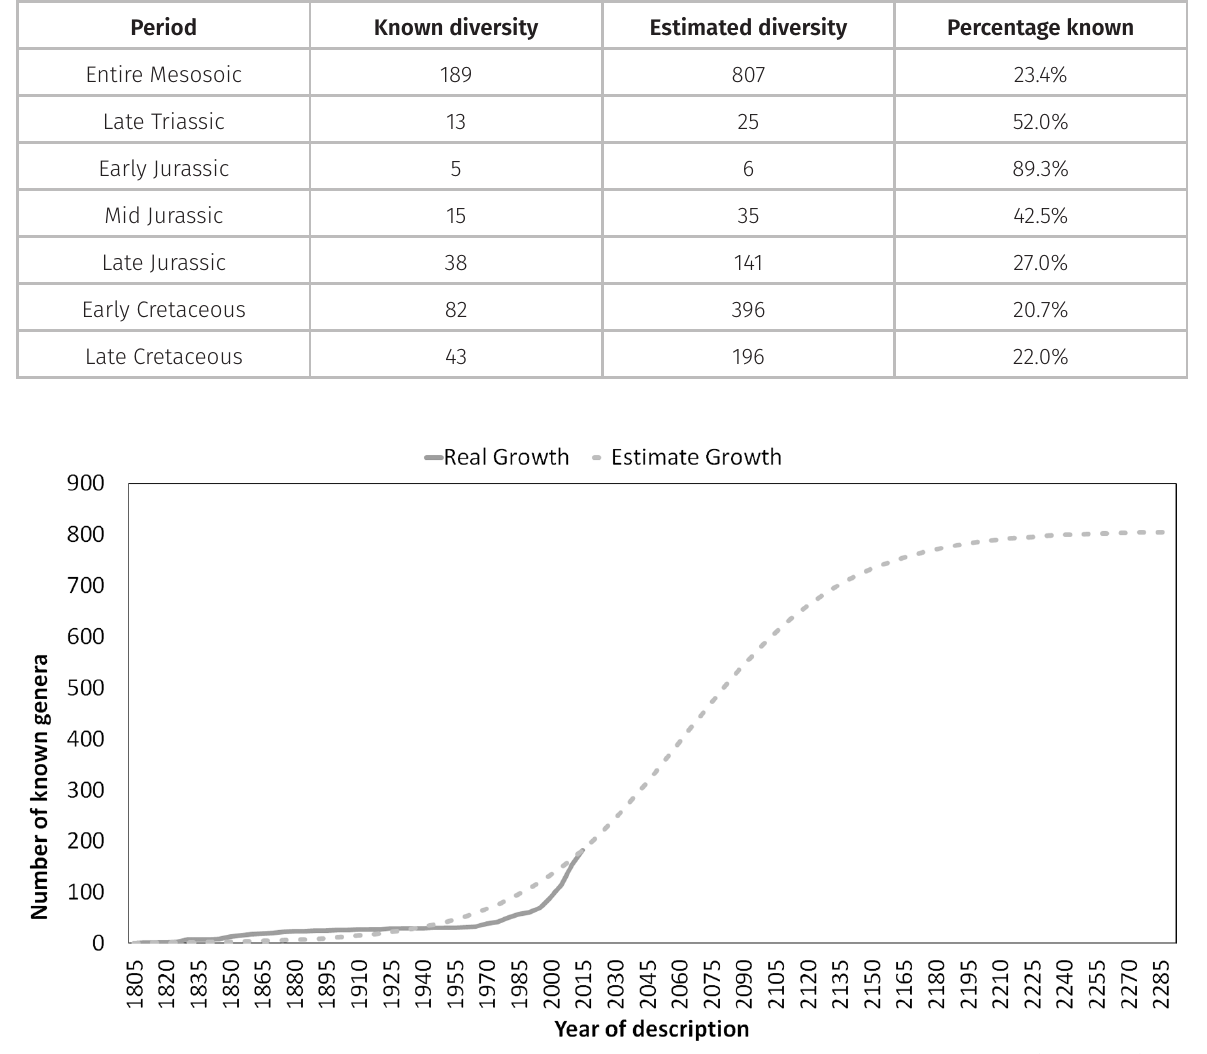
Figure 9. Rate of future pterosaur discoveries using a logistic accumulation curve of the form y=807/(1+806*e^(-0, 0.026026*t)). The dotted line represents the estimated curve, and the solid line corresponds to the known growth.